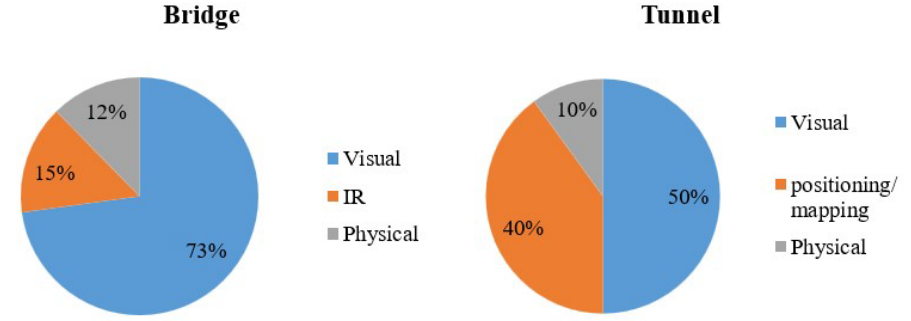
Figure 2. Percentage of the main UAV-based applications for bridge and tunnel